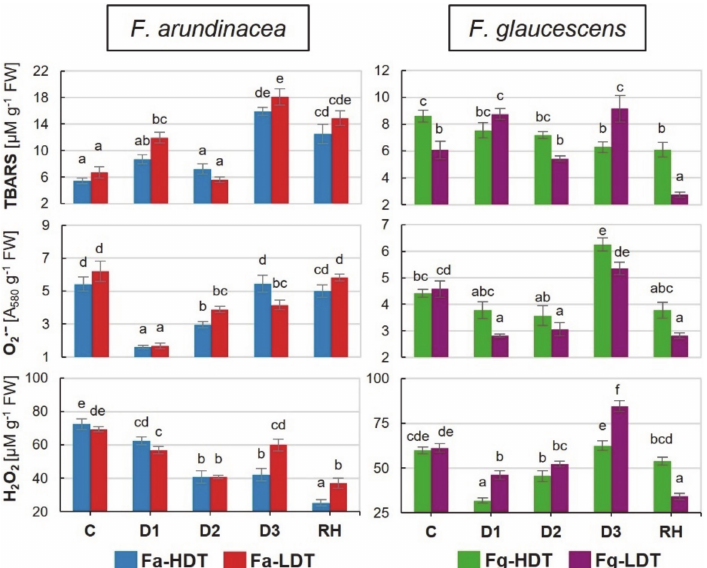
Figure 5. Thiobarbituric-reactive substances ( TBARS) , superoxide anion radical ( O 2 •− ) and hydrogen peroxide content ( H 2 O 2 ) in two genotypes of F. arundinacea (Fa-HDT, Fa-LDT) and F. glaucescens (Fg-HDT, Fg-LDT) before stress treatment (C), on the 3rd (D1), 6th (D2), and 11th (D3) day of water deficit and 10 days after re-hydration initiation (RH). Error bars represent the standard errors (SE) of three biological and technical replicates. Homogeneity groups are denoted by the same letters, according to Fischer LSD test ( p =